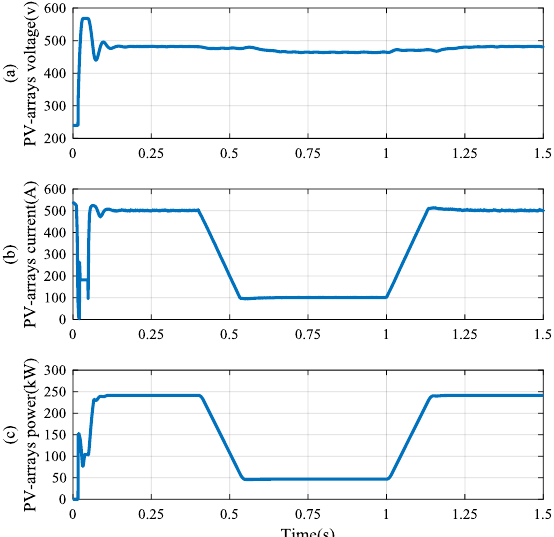
Figure 10. Simulation waveforms of PV-arrays. (a) Output voltage (v); (b) Output current (A); (c) Output power (kW)